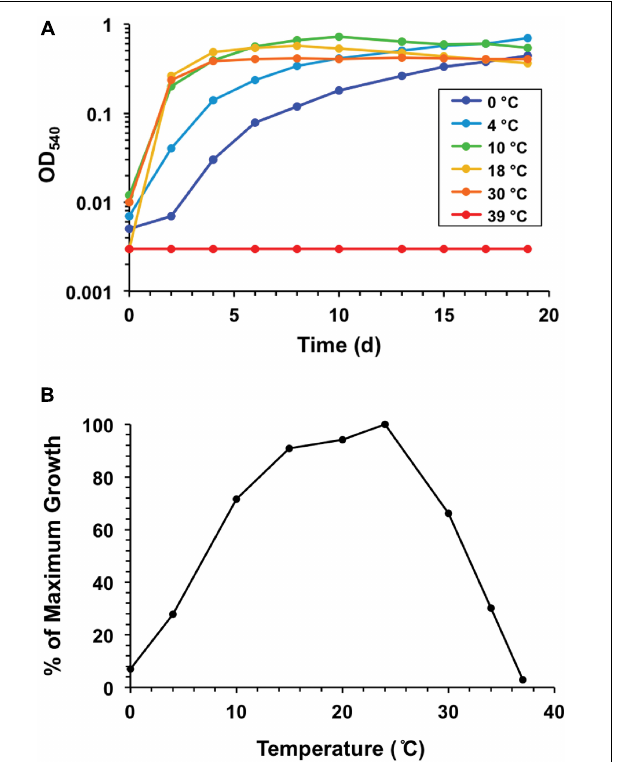
FIGURE 6 | Growth response to temperature for strain LFY10. (A) Growth of strain LFY10 over a range of temperatures. Strong growth at low temperatures (0, 4, and 10 ◦ C) in combination with no growth at 39 ◦ C demonstrates clear cold adaptation. (B) Expression of growth rate data as percent maximum growth. The temperature supporting the highest cell density after one week of incubation was assigned a value of 100, and the percentage of maximum growth was calculated for each remaining temperature. Slow growth at − 2 ◦ C was observed (data not shown). Of the eight Lake Fryxell isolates obtained in this study, strain LFY10 showed the fastest growth rate at 0 ◦ C and the widest temperature range for growth ( Table 1